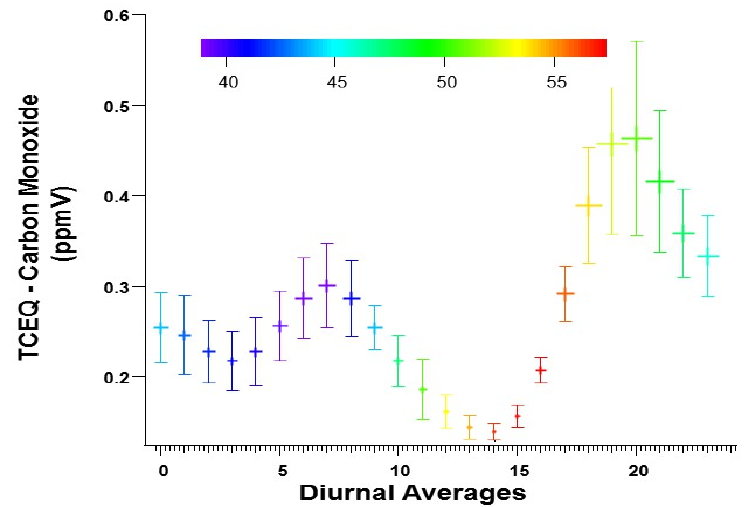
Figure 3. Carbon monoxide molar mixing ratios in parts per million by volume diurnally averaged over January 2022 data from the Texas Commission on Environmental Quality monitoring station at Chamizal National Park, CAM41. The graph has been temperature-coded, with the lowest temperatures toward the blue-purple ends and higher temperatures toward the orange red. After 4:00 PM the temperatures start to decrease, and the CO concentration increases. Table 1. The average and maximum values of the BC and BrC Babs (Babs, Mm − 1 ) for\the three prominent peaks in Figures 2a,b and 3.